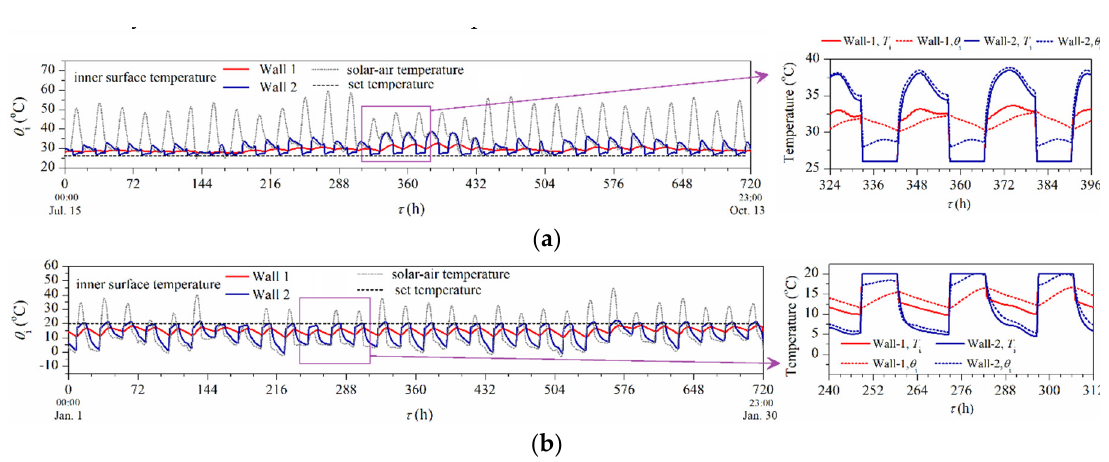
Figure 6. Comparisons between the calculated and experimental data of indoor air and interior surface temperature.